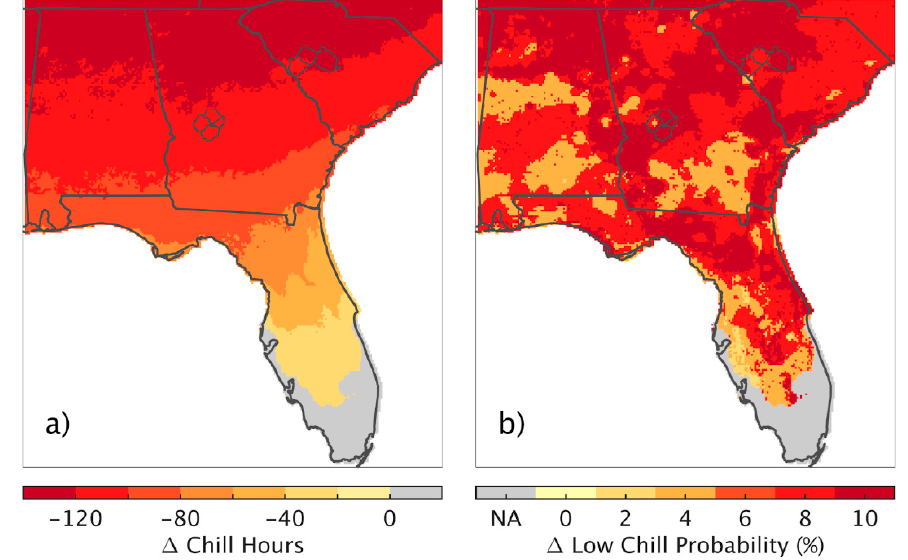
Figure 2. ( a ) The average change in 1981–2017 observed winter chill hours due to the influence of anthropogenic climate change (23-model median). ( b ) The change in the probability of a low-chill winter as a result of climate change, shown as 1981–2017 observed minus 1981–2017 counterfactual (23-model median). For both panels, the areas with < 100 chill hours for the 1981–2017 observed climatology are masked in grey.